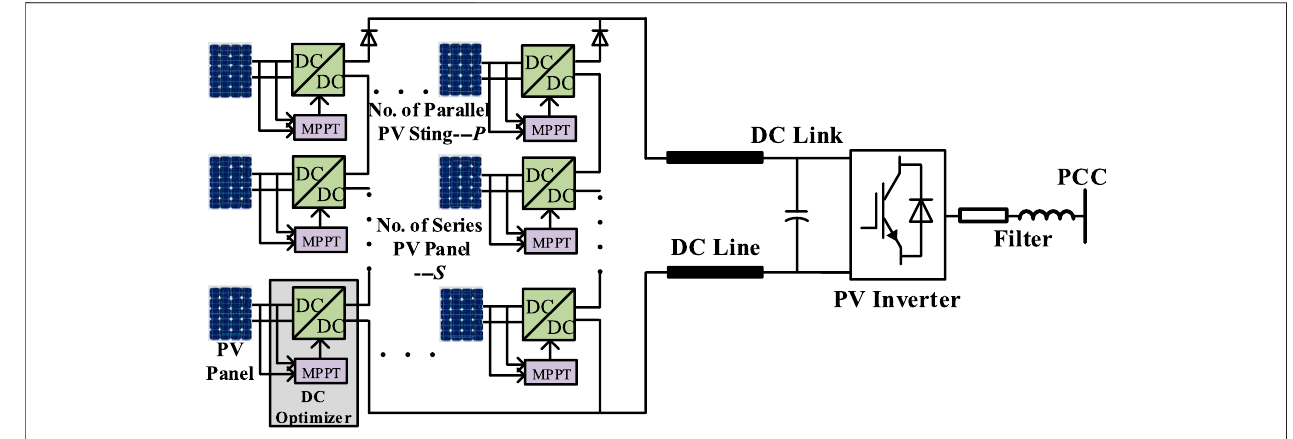
FIGURE 1 | Overall structure of DCO-based distributed